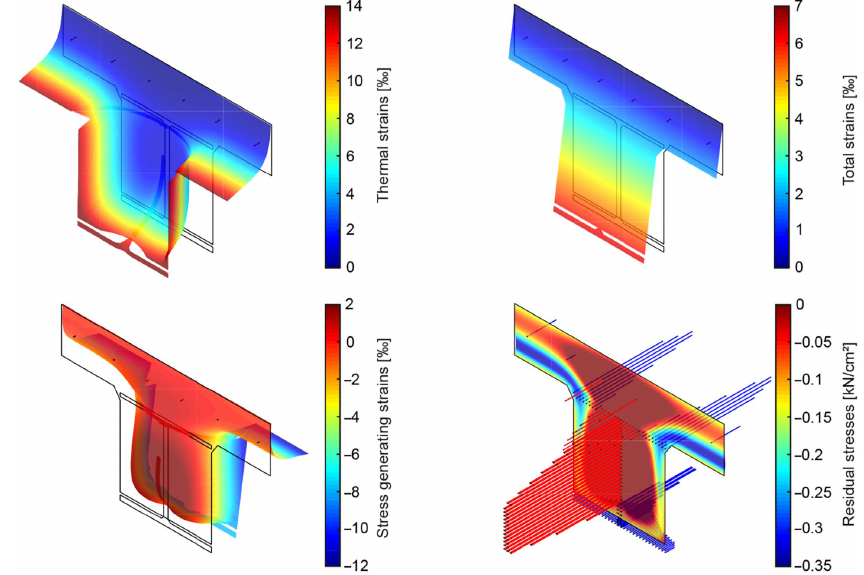
Fig. 8. Thermal, stress free strains (top left), stress generating strains (bottom left), total strains (top right) and residual stresses (bottom right) for 60 minutes fire